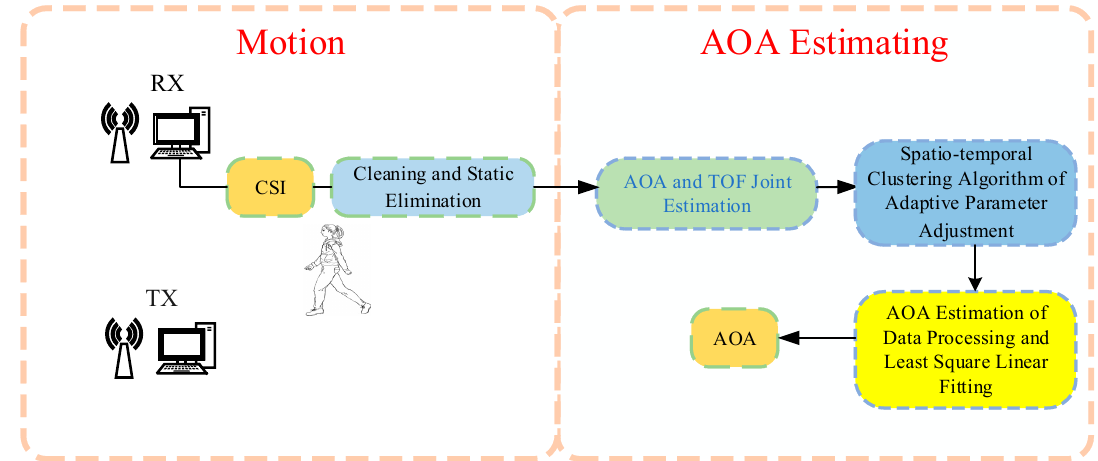
Figure 1. Algorithm flow chart (RX is the receiving antenna and TX is the transmitting antenna).